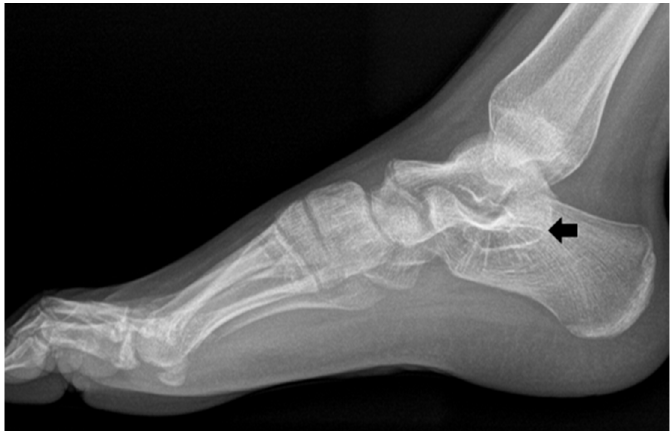
Figure 4. The separation of the talocalcaneal coalition (arrow) is maintained on plain radiographs at two years follow up.